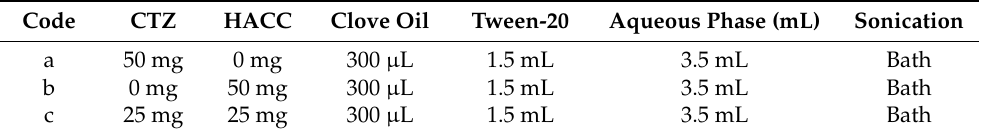
Table 1. Three sets of microemulsion compositions.